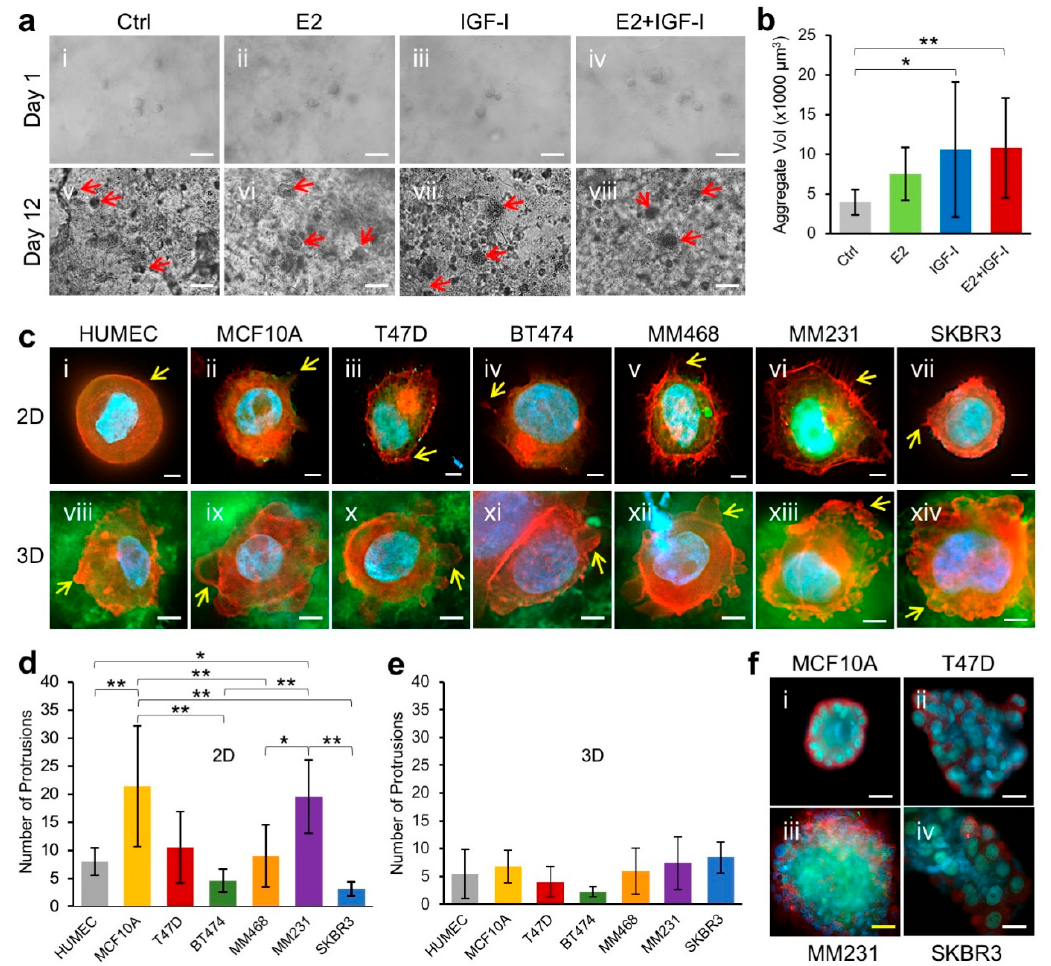
Figure 4. HB-TMG support of human breast epithelial cell 3D growth. ( a ) MCF10A cell suspending growth within HB-TMG in the presence or absence of E2 or/and IGF-I stimulation. Arrows, cell spheres. Scale bars, 50 µ m. ( b ) Quantification of the volumes (vol) of the Day 12 MCF10A cell 3D aggregates shown in ( a ). * p < 0.05; ** p < 0.01. ( c ) IF staining of normal breast or breast cancer epithelial cell culture on 2D surfaces or 3D HB-TMG. Arrows, cell protrusions. Red, phalloidin; green, Col I; blue, nucleus Hoechst staining. Scale bars, 5 μ m. ( d ) Quantification of cell protrusions in 2D cultures. * p < 0.05; ** p < 0.01. ( e ) Quantification of cell protrusions in 3D cultures. ( f ) IF staining of acini formation of normal breast or breast cancer epithelial cells. Red, β 4 integrin; green, E-cadherin; blue, nucleus Hoechst staining. Scale bars: c-i, c-ii, and c-iv, 20 μ m; c-iii, 50 μ m.